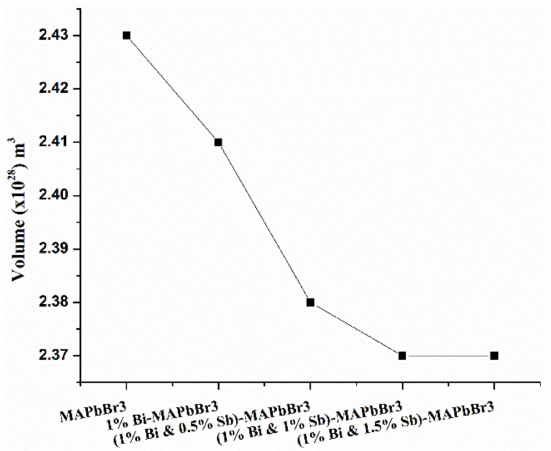
Figure 4. The volume of pure MAPbBr3 and co-doped (1% Bi and 0.5%, 1% and 1.5%